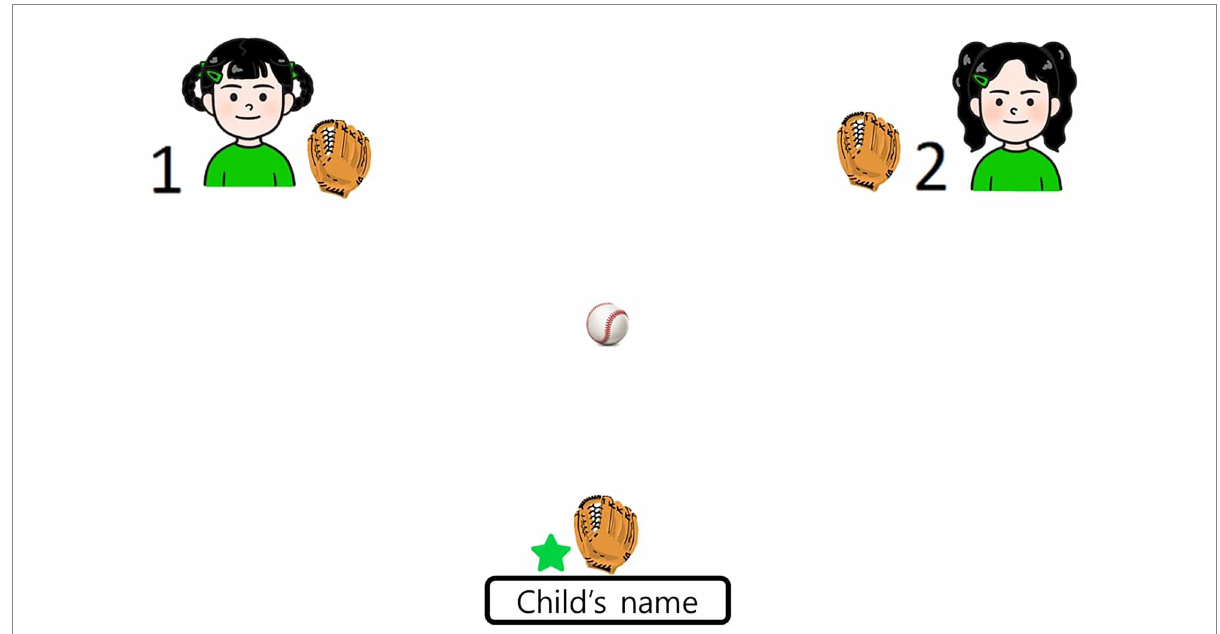
FIGURE 1 Example of Cyberball phase. In the Ingroup-inclusion condition, children received 5 ball tosses out of a total of 15 tosses, while in the Ingroup- exclusion conditions they received only 1 ball